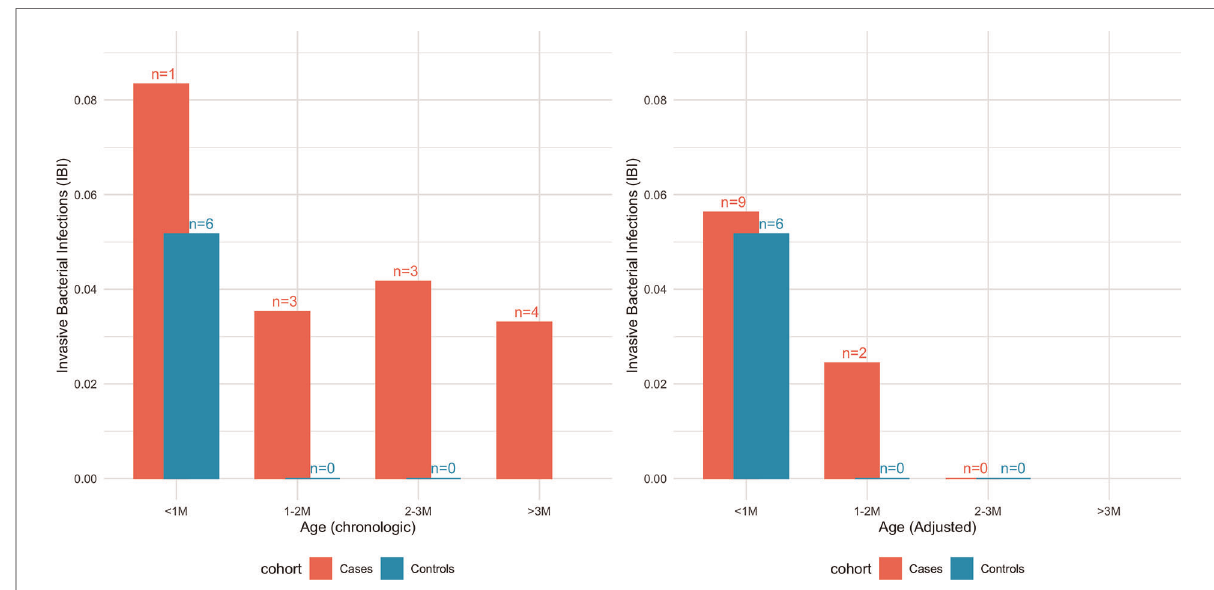
FIGURE 3 The rate of invasive bacterial infections (IBI) among ex-premature cases and full-term controls by age in month, using only chronologic ages (left) and chronologic age for controls and adjusted age for cases